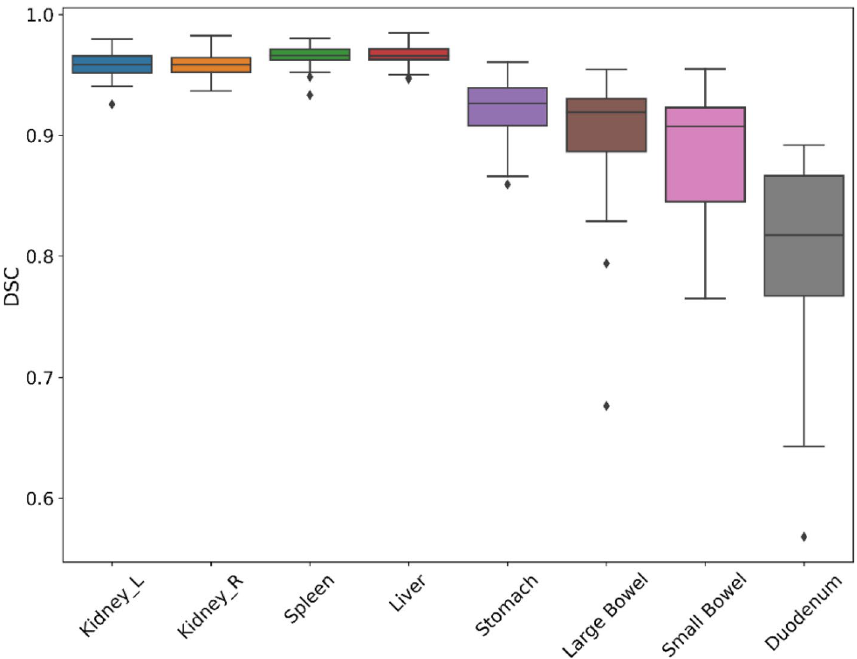
Figure 2. Box and whisker plots of Dice similarity coefficient (DSC) distance between ground-truth and automatically generated contours by our tool on contrast-enhanced CT images. The central line represents the median value. The border of the box represents the 25th and 75th percentiles. The outliers are represented by diamond markers.